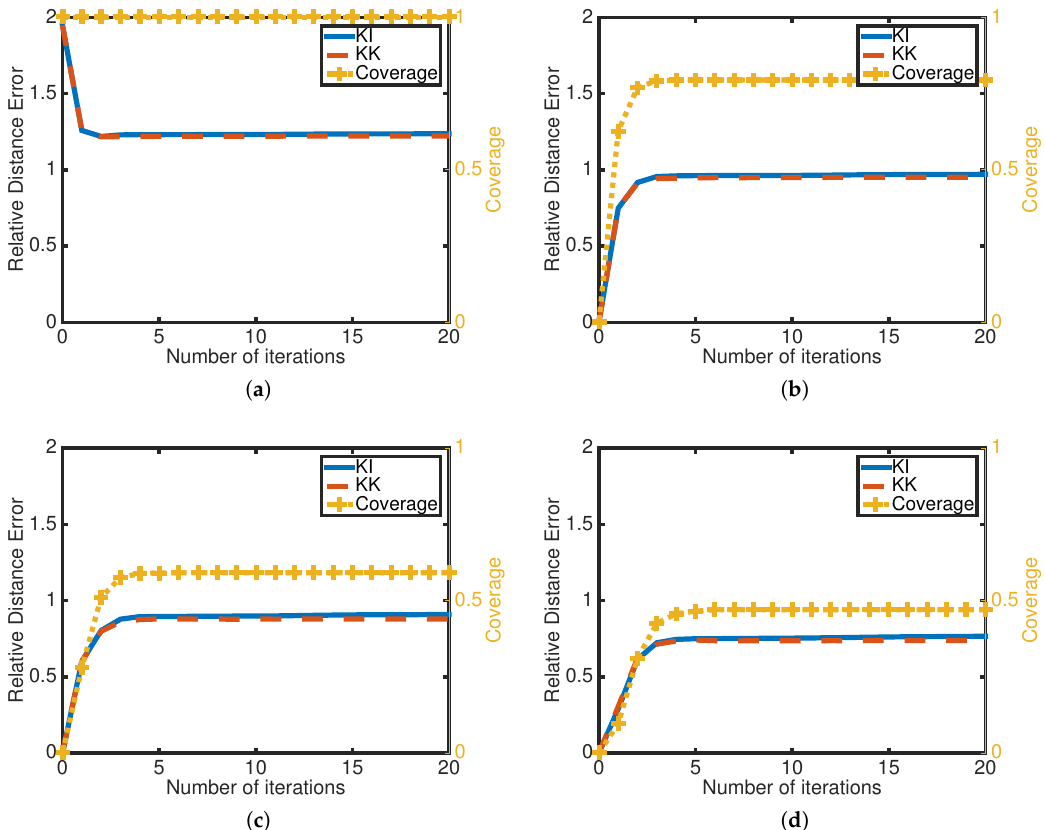
Figure 7. Relative localization error and coverage in sparse networks as a function of number of iterations for KI and KK with ( a ) zero connected beacon criterion, ( b ) one connected beacon criterion, ( c ) two connected beacons criterion, and ( d ) three connected beacons